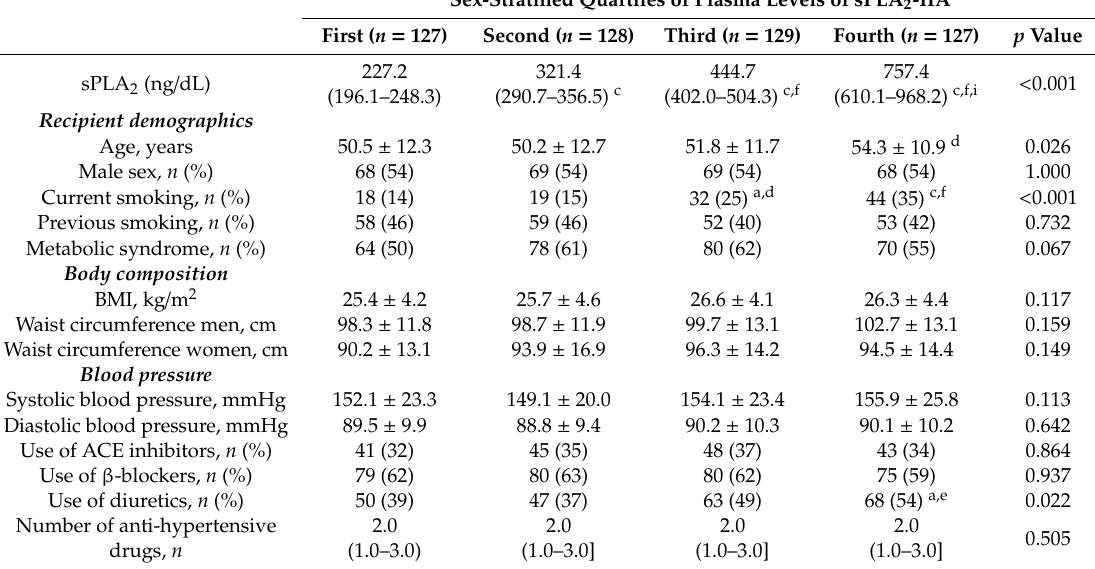
Table 1. Baseline characteristics according to sex-stratified quartiles of plasma levels of group IIA secretory phospholipase A 2 (sPLA 2